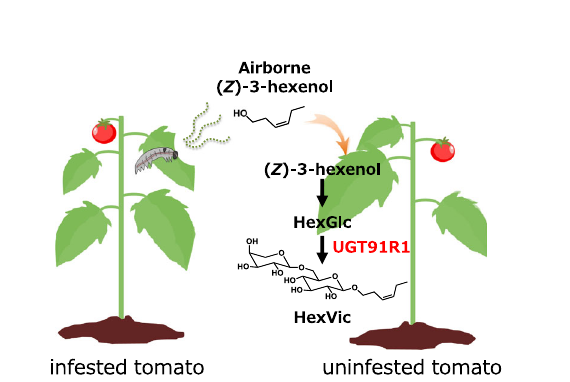
Fig.4|Metabolicchangesin UGT91R1 -knockoutand-overexpressedtomatoes. a HexVic content in the leaves of S. lycopersicum cv. M82 and UGT91R1 -knockout lines ( UGT91R1 -KO) exposedto ( Z )-3-hexenol. Error bars indicate standarderror of the mean from four independent plants. Statistical signi fi cance was determined using an unpaired two-tailed t -test, and reported as **** p <0.0001. FW, fresh weight. b HexVic content in the leaves of UGT91R1- overexpressed IL11-1 and IL11-2 ( UGT91R1 -OX-1 and UGT91R1 -OX-2, respectively) exposed to ( Z )-3-hexenol, respectively. Error bars indicate standard error of the mean from 12 independent plants. FW, fresh weight. Data were analyzed using the one-way ANOVA with the Tukey ’ s test for multiple comparison. Statistical signi fi cance is reported as ** p <0.05.